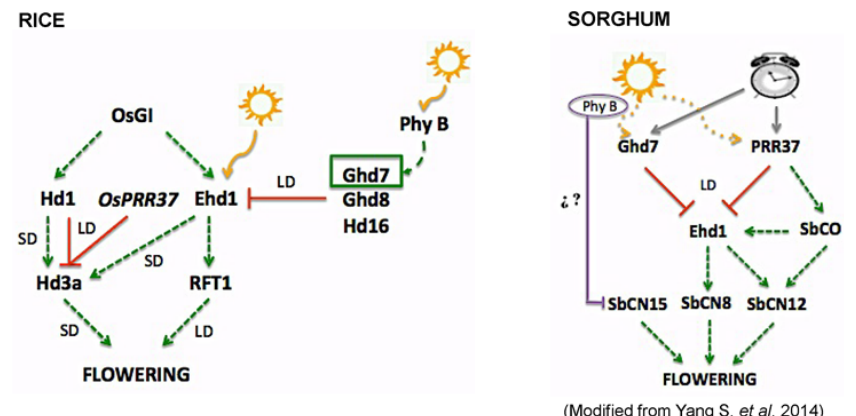
Figure 1. A simplified model of flowering time under short-day (SD) and long-day (LD) conditions in rice and sorghum. A dashed green arrow indicates transcriptional activation and a solid red line indicates transcriptional repression.